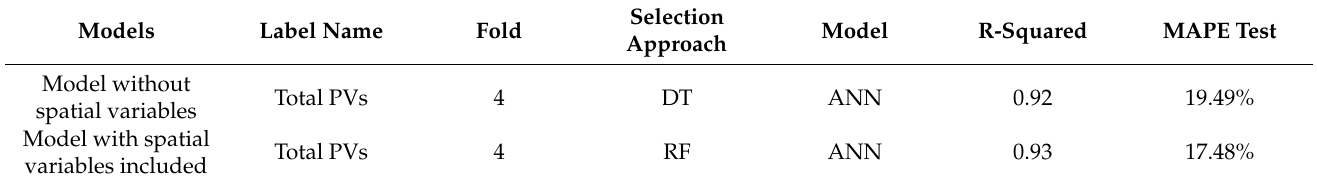
Table 7. Comparison of the ANN models for the test data set.